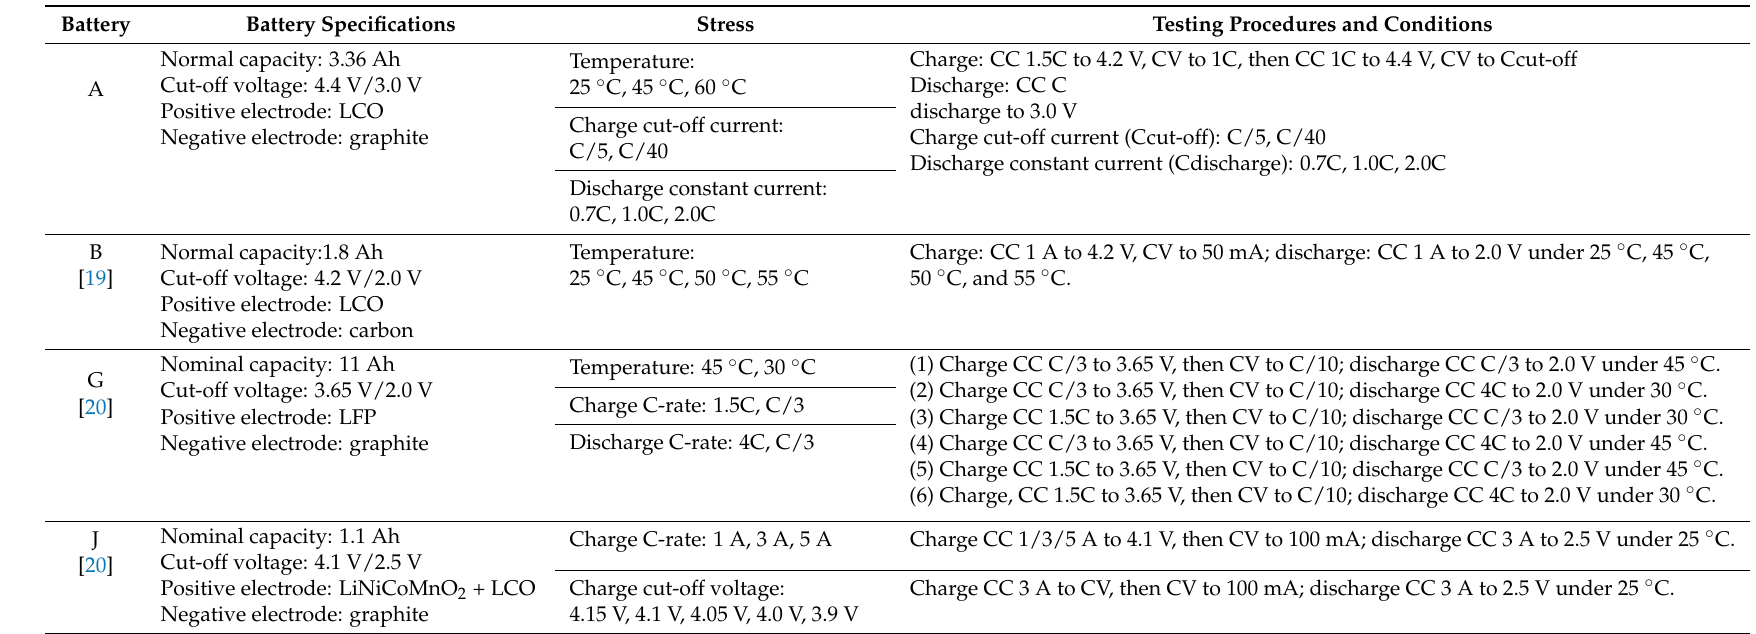
Table 3. Battery specification and testing